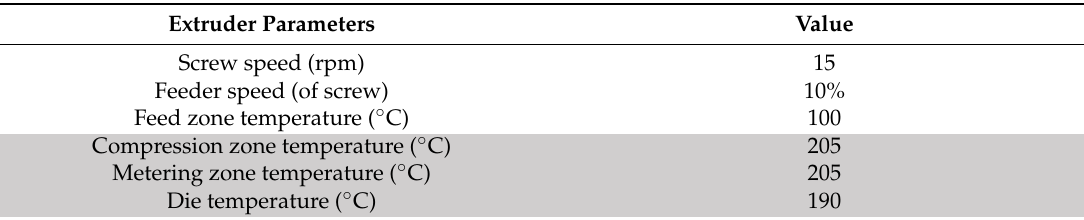
Table 1. Employed extrusion parameters.